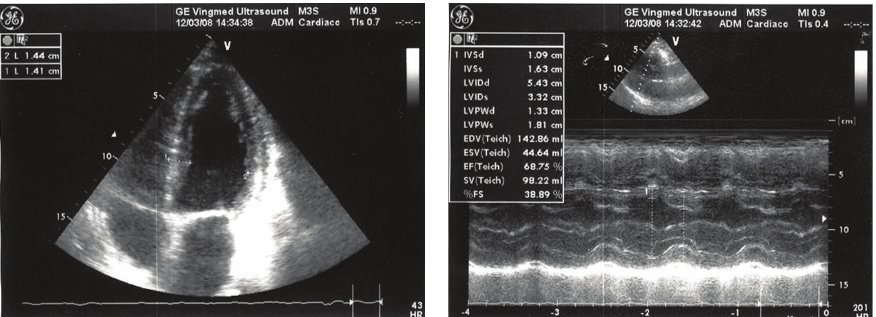
Figure 4: Case 2: echocardiography after the bortezomib cycles.